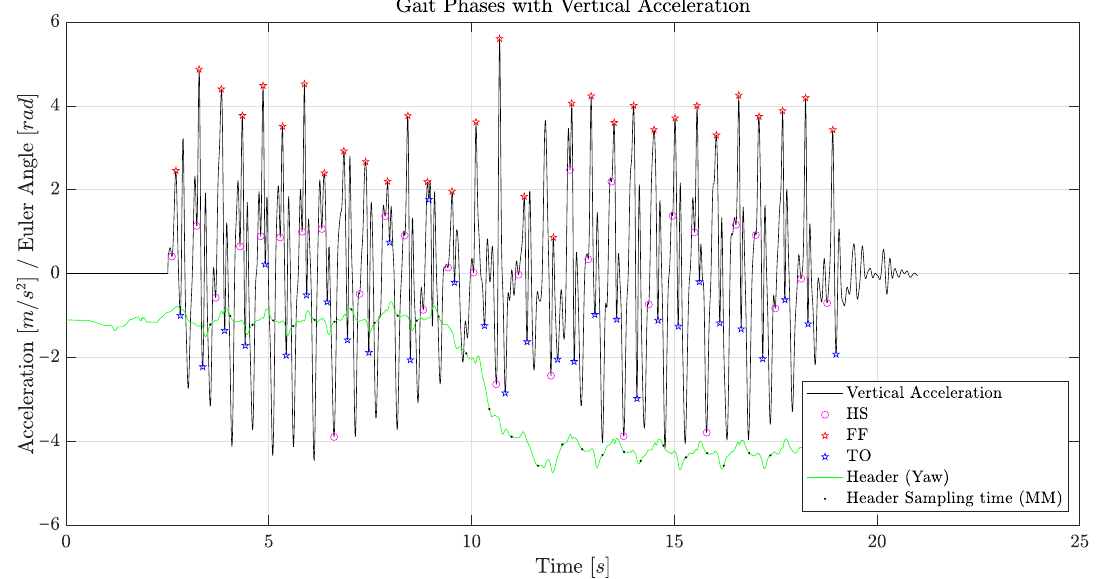
Figure 7. Gait phases obtained from the vertical accelerometer of the BTS sensor. Data recordings were carried out on two different healthy subjects: a 34-year-old male and a 24-year-old female. Subjects were asked to walk at their natural speed. The sensors were positioned below the line that connects the two dimples of the Venus-lumbosacral passage, which corresponds to the S1–S2 vertebrae, and were firmly attached to the body with the supplied straps. Every measurement was taken six times with each of the three sensors for the male patient, while only the BTS and MTw sensors were measured for the female patient. The reason was that the data from the WIVA sensor turned out to be considerably less accurate, compared to the other two, as further discussed in Section